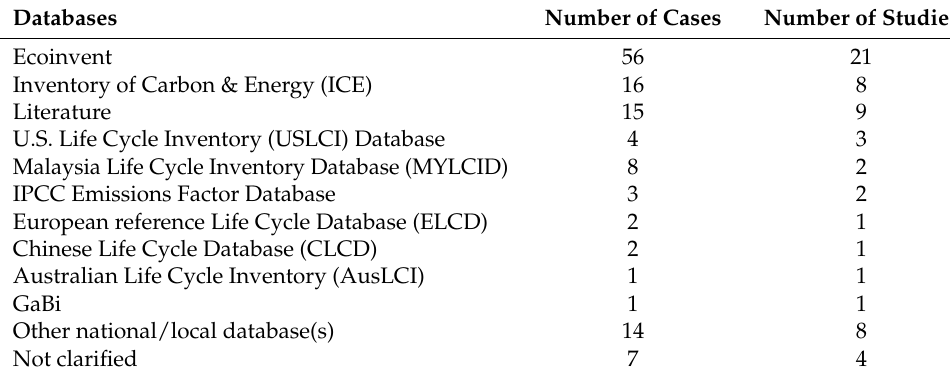
Table 4. Carbon inventory